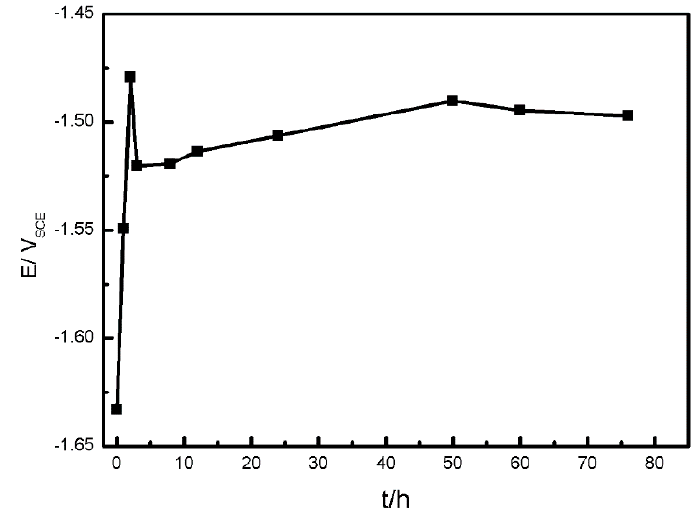
Figure 2. OCP dependence on immersion time of AZ91D in simulated HA solution.